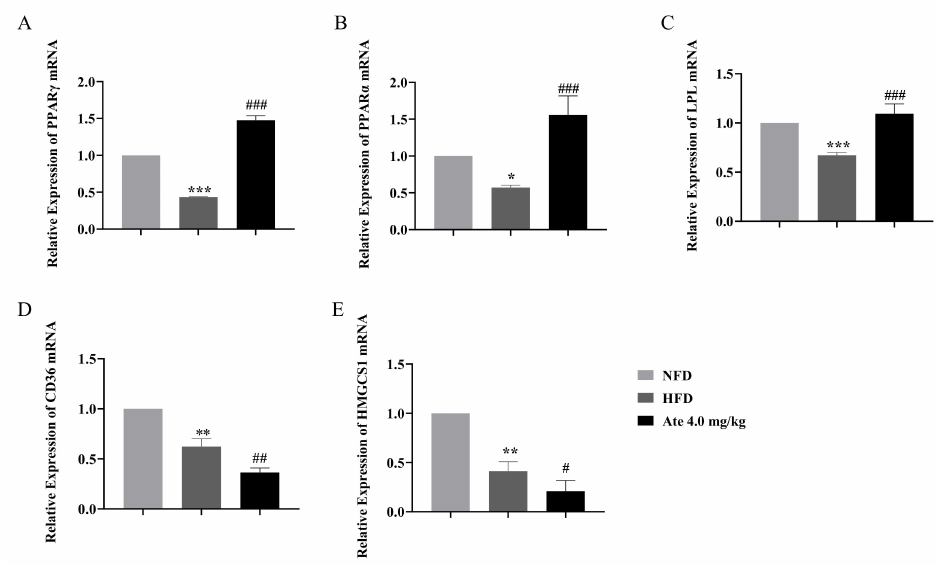
Figure 8. mRNA expression of genes related to the PPAR-signaling pathway. The gene expression of ( A ) PPAR γ , ( B ) PPAR α , ( C ) LPL, ( D ) CD36, and ( E ) HMGCS1 after modeling and treatment with Ate. All data are shown as mean ± SEM, n = 6. * p < 0.05, ** p < 0.01, and *** p < 0.001 compared with the NFD group; # p < 0.05, ## p < 0.01 and ### p < 0.001 compared with the HFD